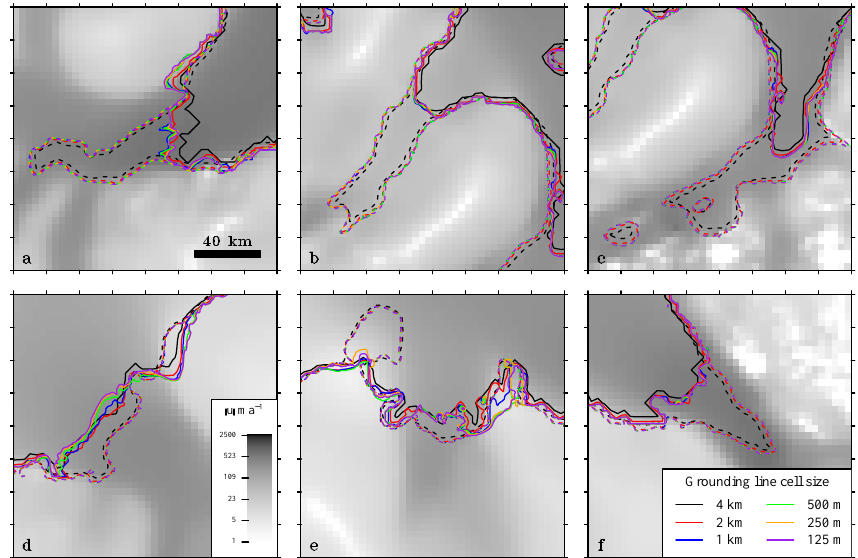
Figure 4. Results of the 200-year grounding line convergence experiment with increasing levels of grounding line resolution for the major ice streams within the model domain. Grounding line locations are colour-coded to indicate the degree of grounding line refinement; initial positions ( t = 0 years) are shown as dashed lines and final positions as solid lines. (a) Evans Ice Stream, (b) Carlson Inlet, (c) Rutford Ice Stream, (d) Institute Ice Stream, (e) Möller Ice Stream and (f) Foundation Ice Stream.